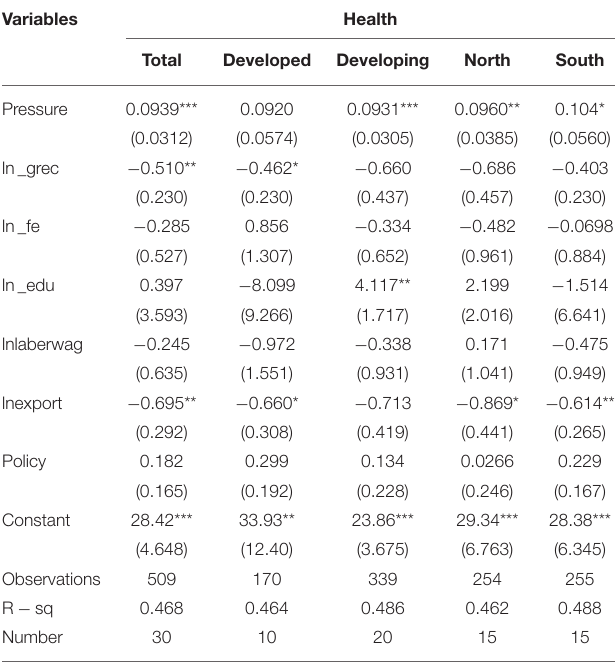
TABLE 3 | Regression analysis and heterogeneity analysis